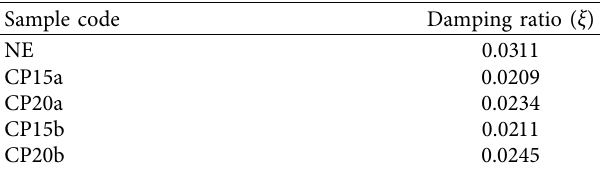
Figure 2: Compressive strength of composites. Table 3: Damping ratios of the